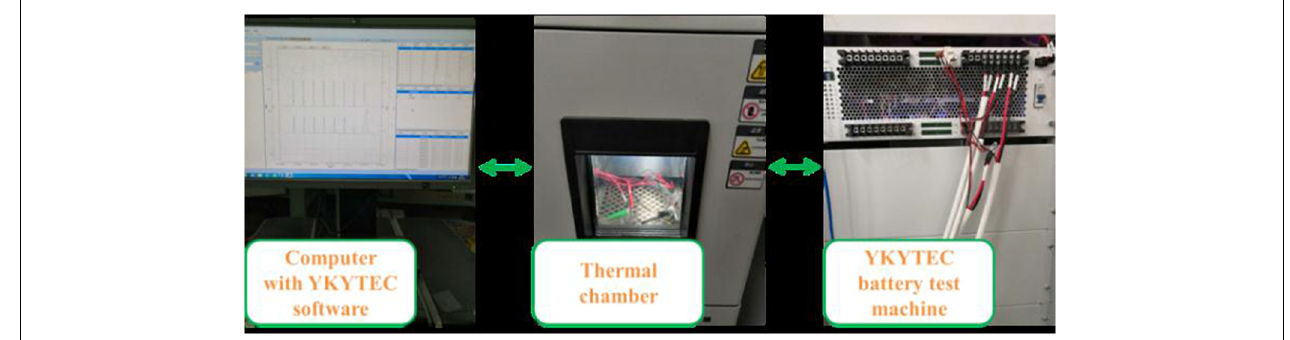
FIGURE 1 | Battery test